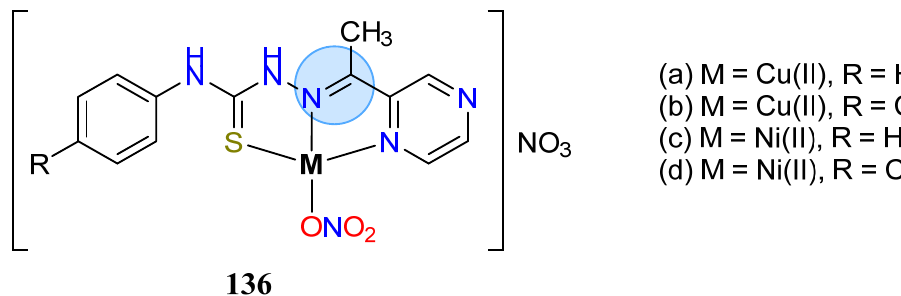
Figure 67. Cu(II) and Ni(II) complexes with NNS tridentate thiosemicarbazones studied for their antibacterial activity. antibacterial